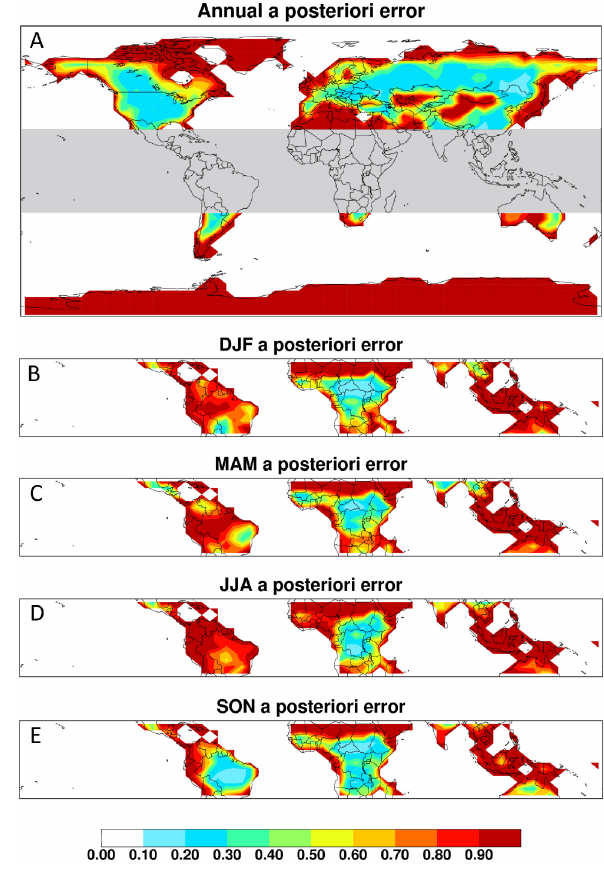
Fig. 6. A posteriori error estimate for the optimized methanol emis- sions (a priori error = 1.0, i.e., 100%). (A) Annual a posteriori error for the extratropics. (B) – (E) Seasonal a posteriori error for the tropics (DJF = December, January February; MAM = March, April, May; JJA = June, July, August; SON = September, October,